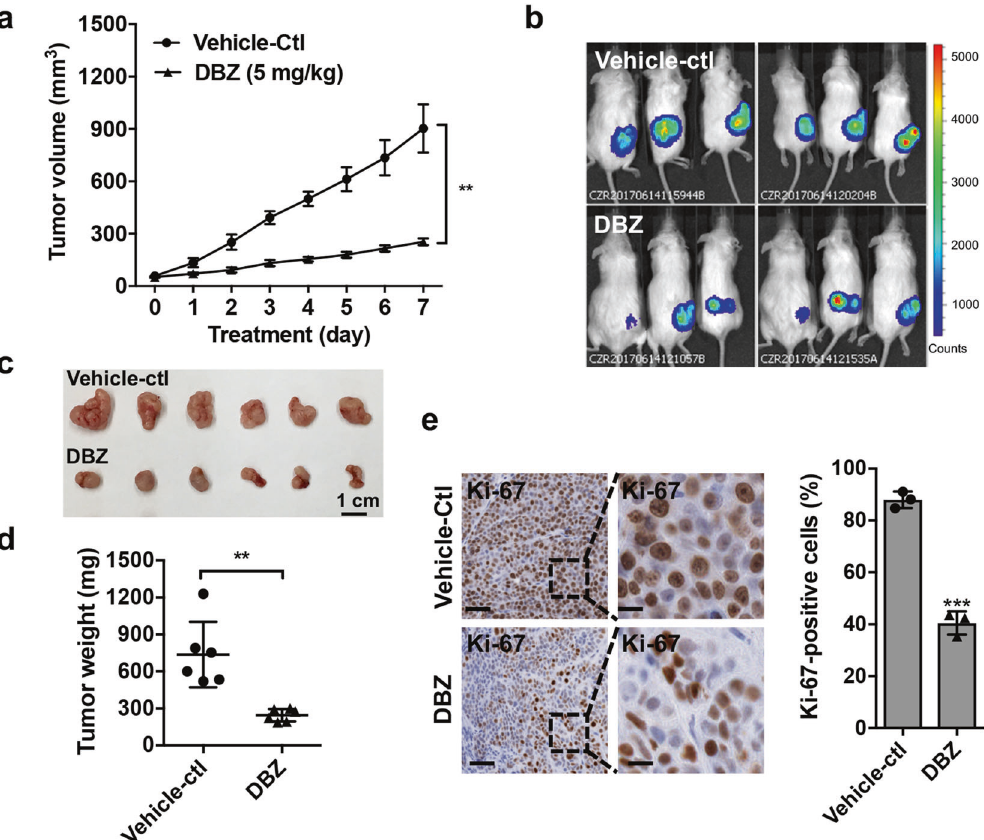
Fig. 5 The γ -secretase inhibitor DBZ suppressed the growth of MEC xenografts. a NOD.SCID mice were subcutaneously injected with luciferase-expressing H3118 MEC cells. When the xenografts grew to ~50 mm 3 , mice were randomly separated and treated with either vehicle only ( n = 6) or 5 mg/kg DBZ ( n = 6) via intraperitoneal injection daily for 7 days. The tumor volumes were measured daily after treatment (** p < 0.01). b – d Bioluminescent imaging of the xenograft tumors ( b ), tumor size ( c ), and tumor weight ( d ) were presented on the fi nal day of treatment. e Representative images showed Ki-67 immunohistochemical staining of H3118-luc xenografts treated with either vehicle control or DBZ (left bar = 100 μ m, right bar = 25 μ m). ImageJ was used to analyze Ki-67-positive cells on the sections of individual tumors ( n = 3) in each group (** p < 0.01; *** p <